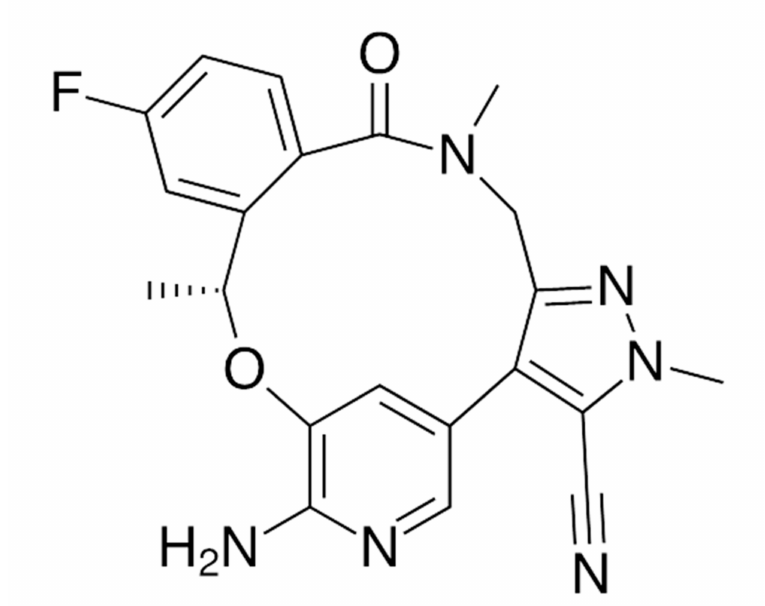
Figure 12. Lorlatinib—a third-generation ALK